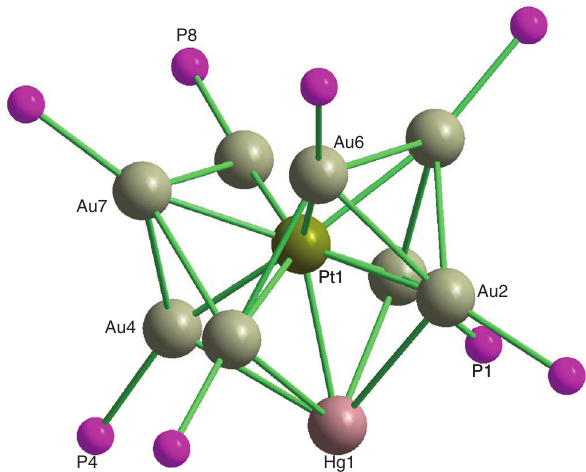
Figure 6 Simplified view of the molecular structure (diamond) of